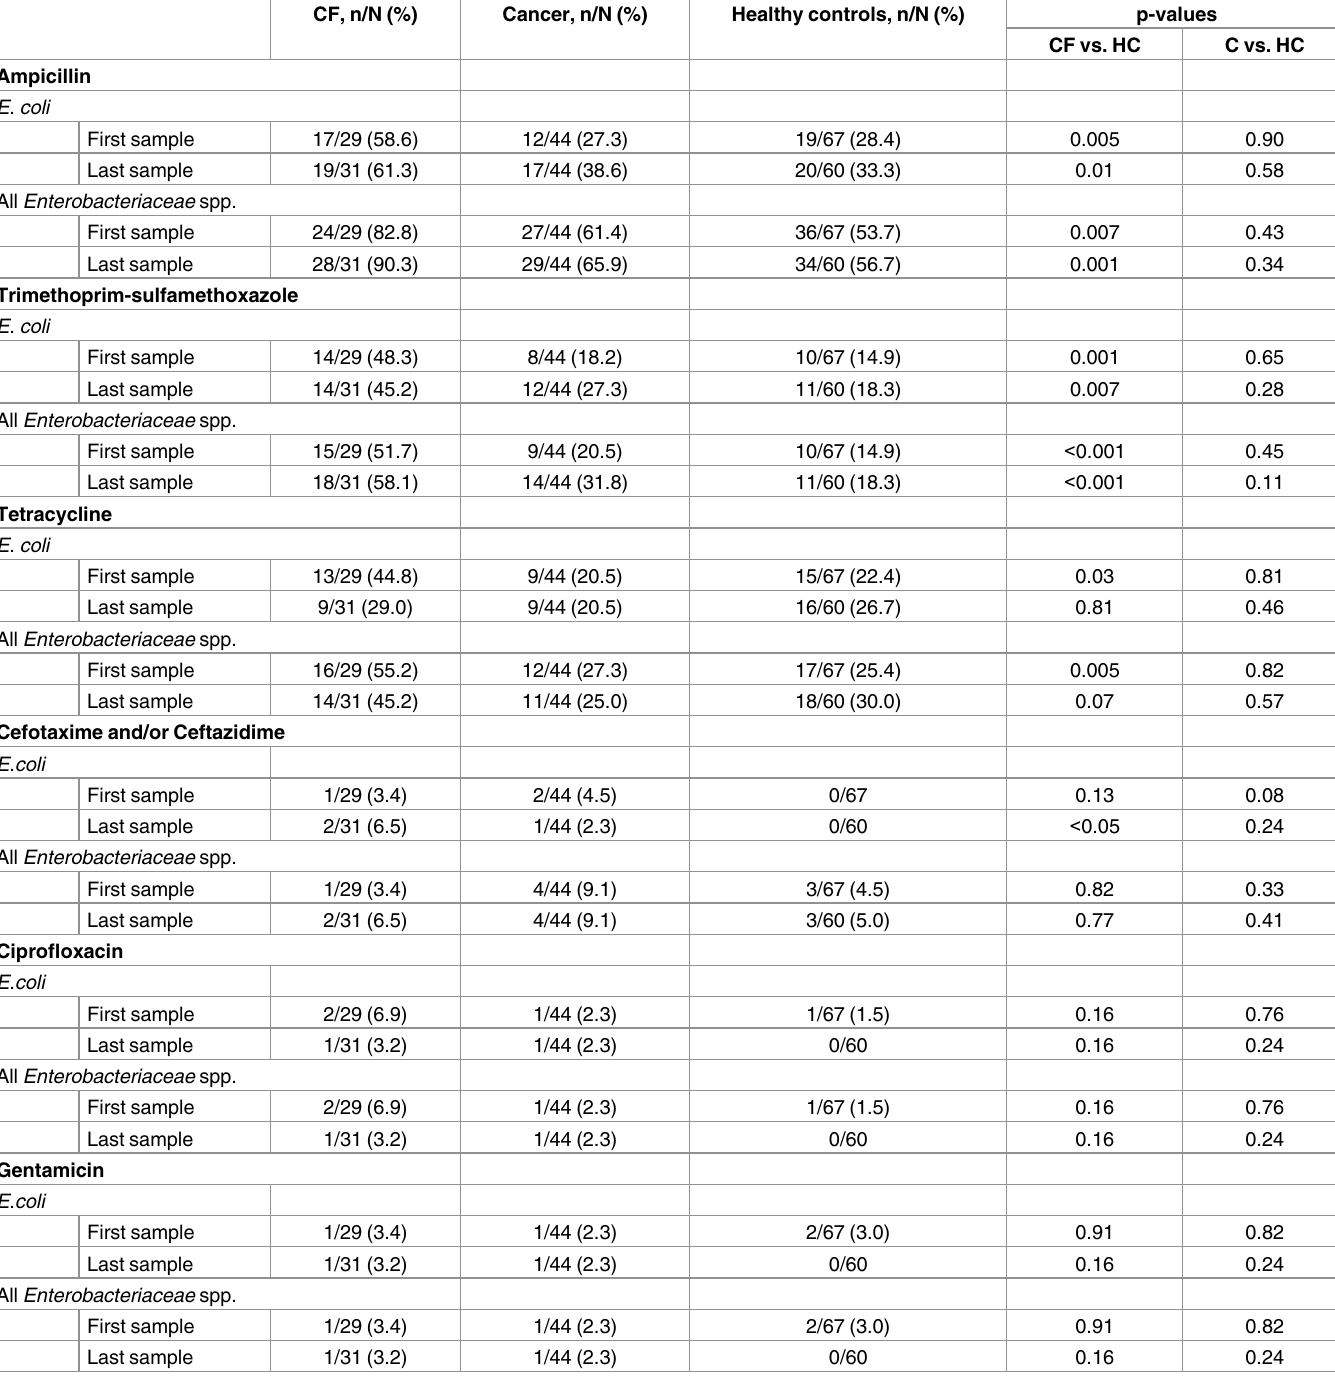
Table 3. Prevalence of antibiotic-resistant isolates of Escherichia coli and all Enterobacteriaceae species combined (including E . coli ) in the first and the last faecal sample from children with cystic fibrosis, cancer and healthy controls (one or more resistant isolates per sample) a